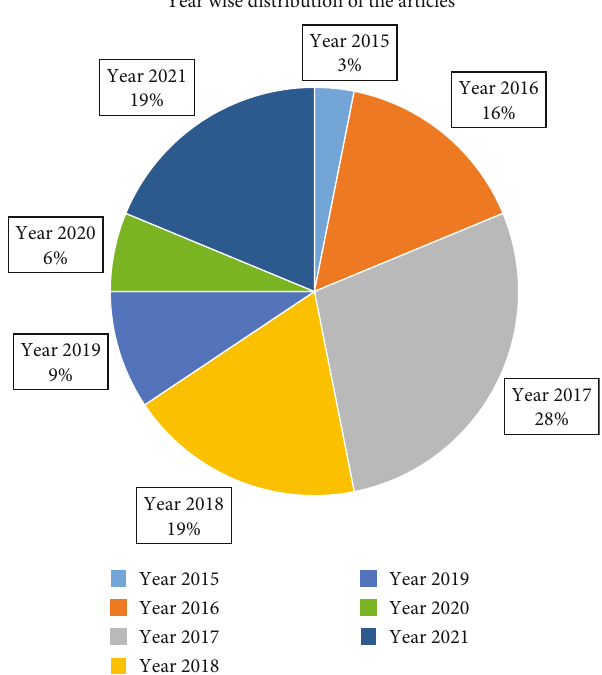
Figure 2: Year-wise distribution of the